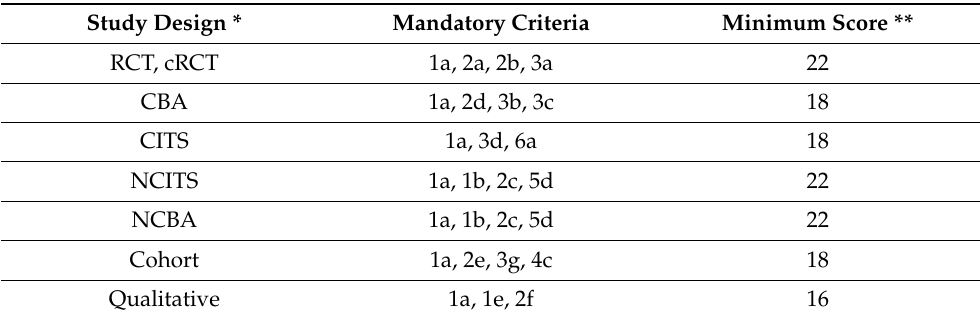
Table A3. ICROMS Decision Matrix—Mandatory Criteria and Minimum Score of Study Type for Inclusion in